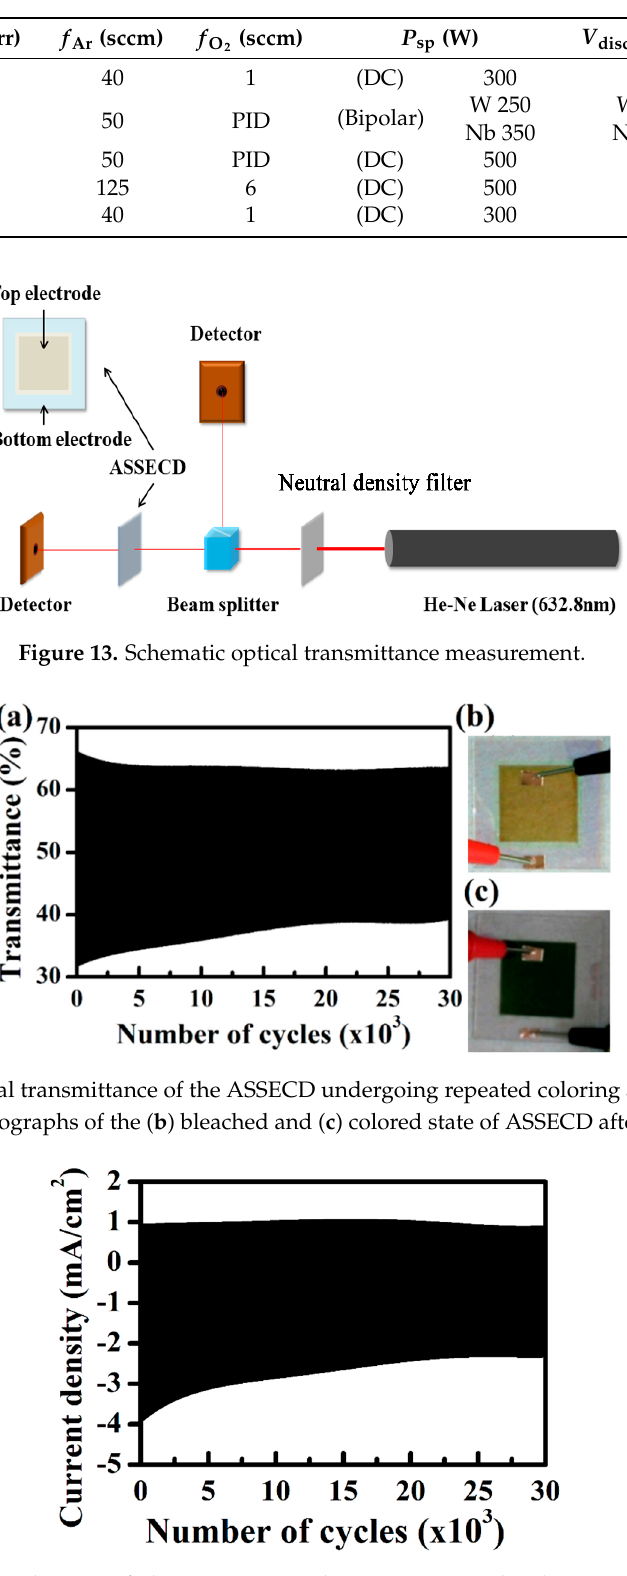
Table 2. Growth sequence and parameters used for all-solid-state electrochromic device.